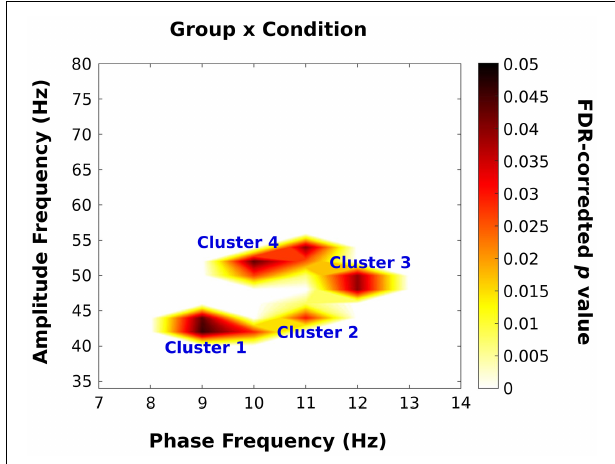
FIGURE 7 | Results of permutation ANOVA analysis on PACz scores. A p value map with false discovery rate (FDR) corrected ps is displayed for the group × condition interaction. Any p value greater than 0.05 was converted to zero. There were 4 alpha/low-gamma clusters that revealed a significant interaction between group and condition. The main effects of group and condition did not retain any significant coupling following statistical analysis and are thus